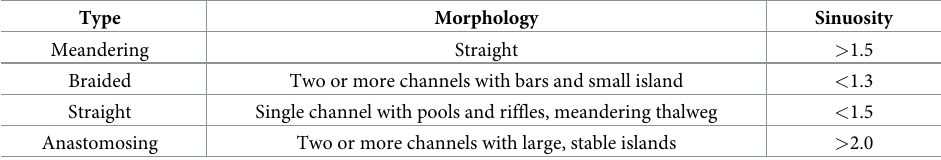
Table 1. Classification of river